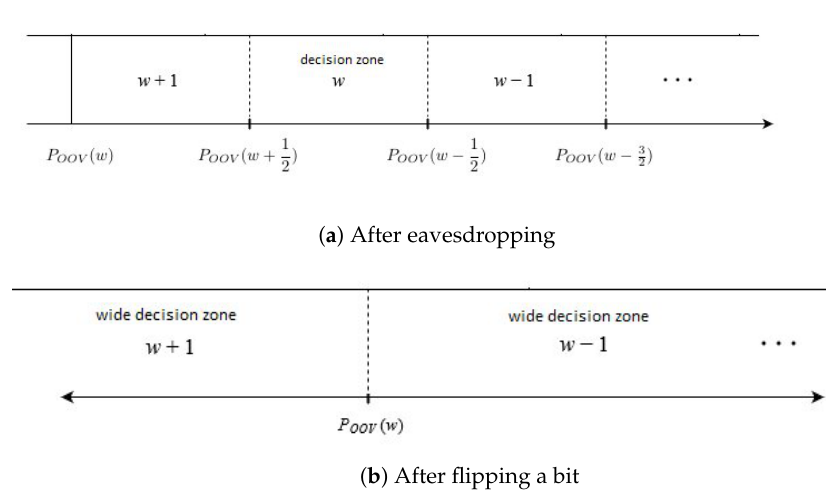
Figure 3. Decision making of the OOV attack Algorithm